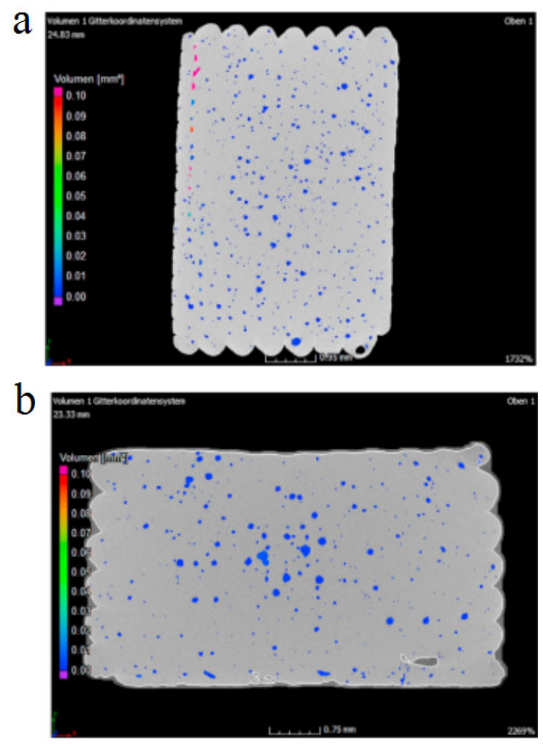
Fig. 41 Micro X-CT images of Si 3 N 4 bars manufactured by DIW: top view of (a) aligned bar; (b) hexagonal bar. Reproduced with permission from Ref. [107], © The Authors